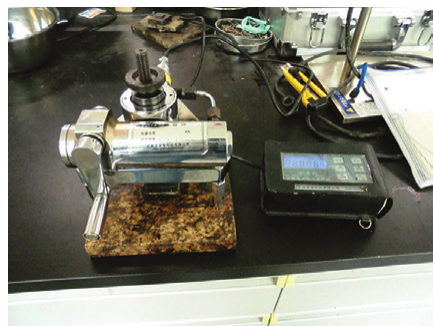
Figure 2. HC-40 hydraulic force measuring device